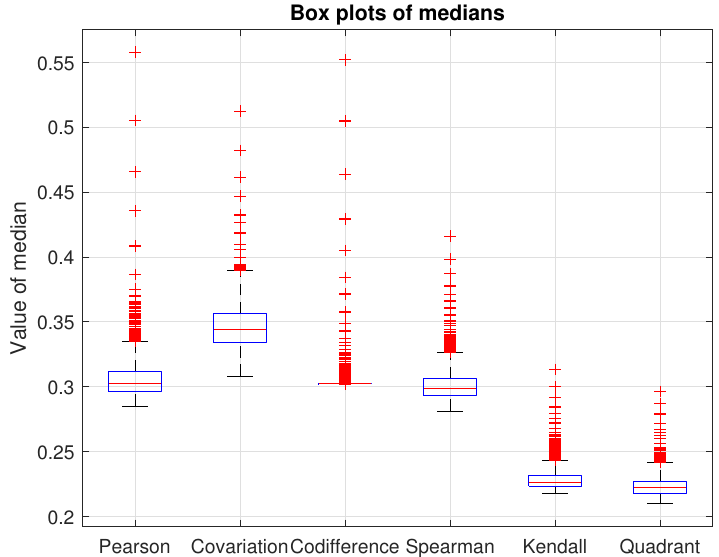
Figure 17. Boxplots of medians associated with heavy-tailed noise (part C of the frequency bands) of the considered auto-similarity maps based on the following measure of dependence: Pearson, Spearman, Kendal autocorrelations, autocovariation and autocodifference for the real signal r 1 . Figure 18 presents the medians of the values of the auto-similarity map for each time lag calculated from the bandwidth corresponding to the informative frequency band with peaks marked in red. Based on that, the IMPI defined in Equation (15) for each measure of dependence is calculated. They are as follows: Pearson autocorrelation—0.085806, autocovariation—0.083281, autocodifference—0.082679, Spearman